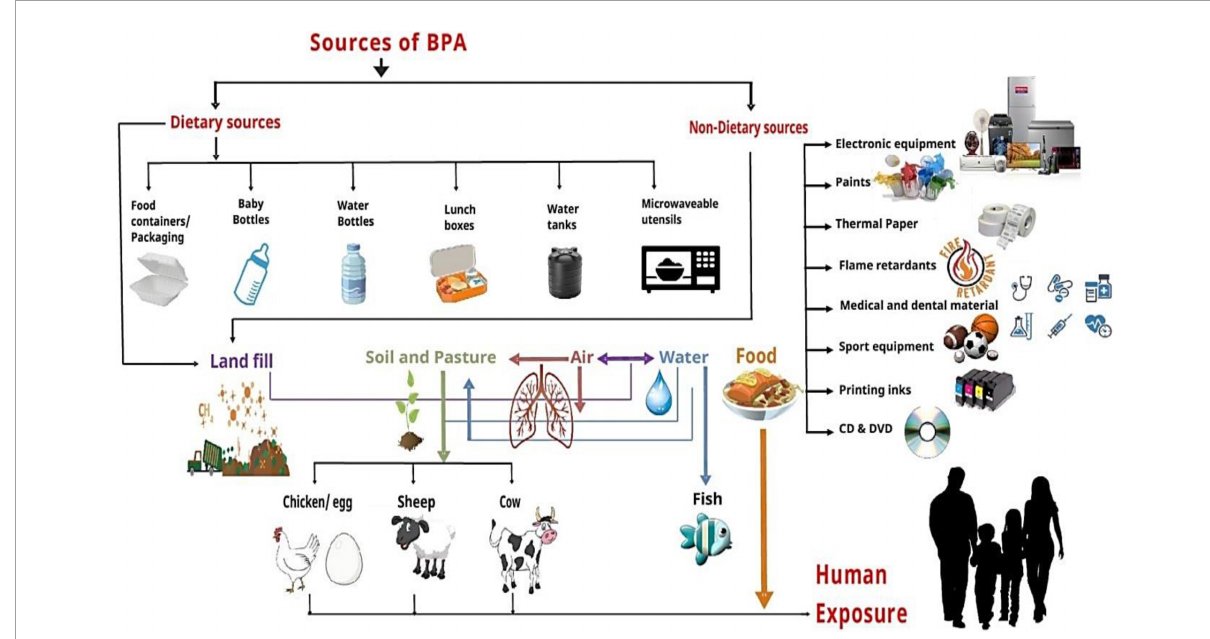
FIGURE1 Humans exposure to BPA via different sources and exposed roots. Dietary sources (food containers/packaging, baby bottles, water bottles, lunch boxes, water tanks, and microwave utensils) and non-dietary sources (electronic equipment, paints, thermal paper, flame retardants, medical and dental materials, sports equipment, printing inks, and DVDs) contaminate landfill, soil, air, water, and food that directly or indirectly affect the human through different exposure